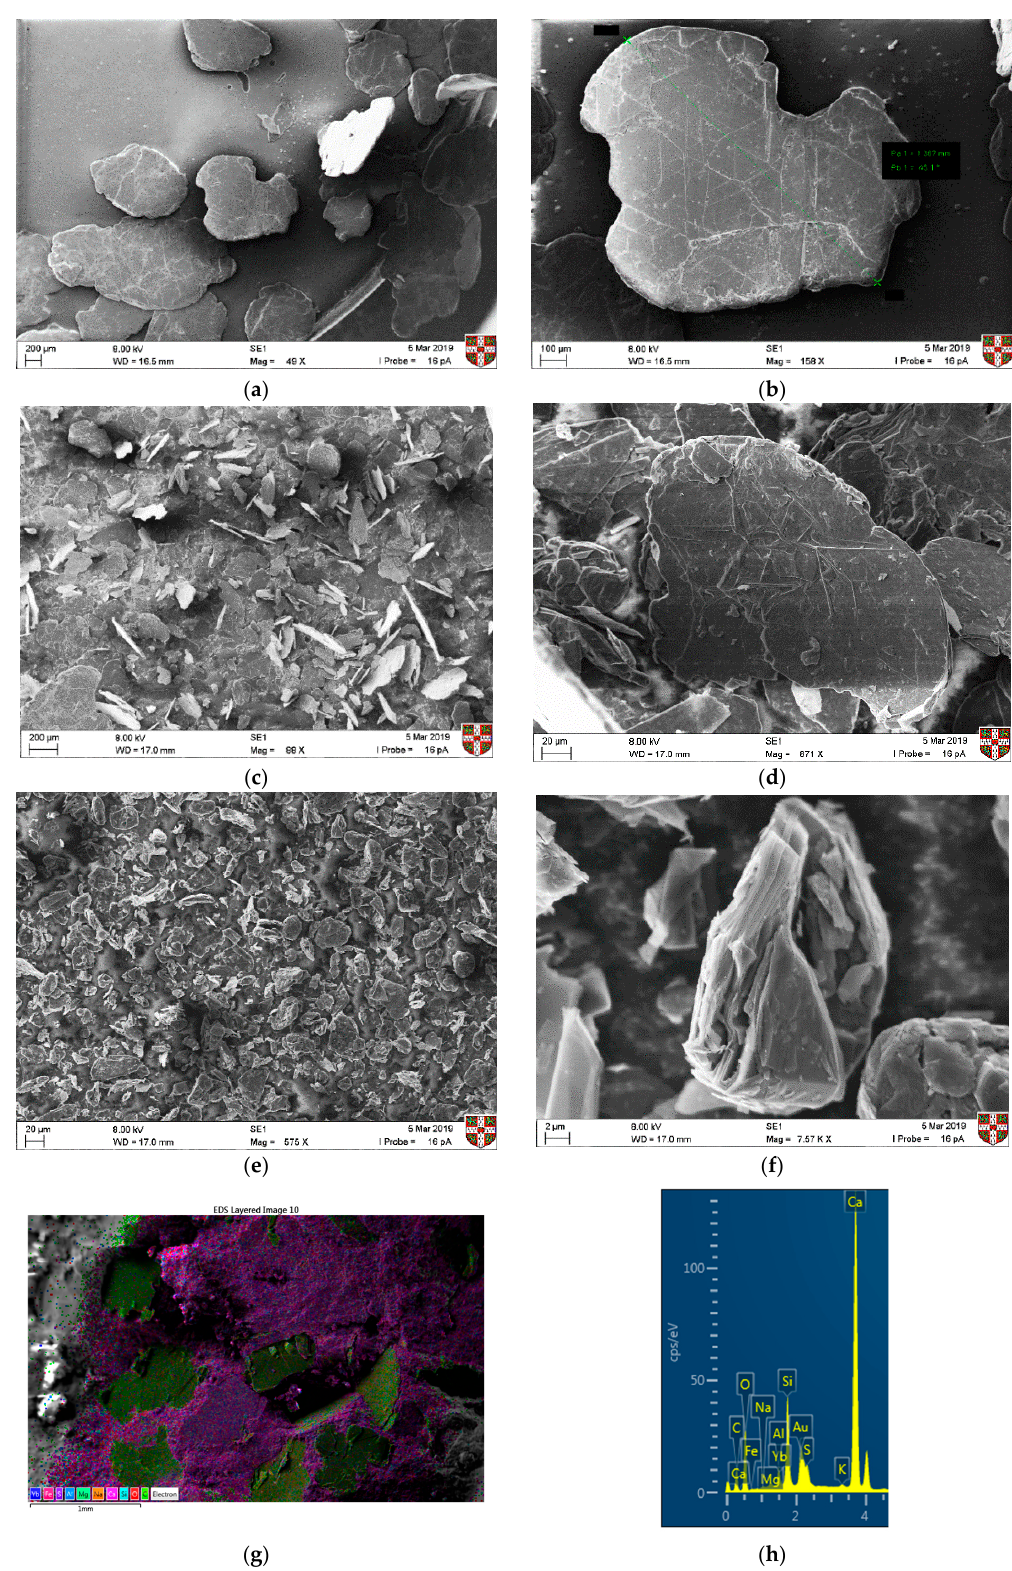
Figure 3. SEM images of the three graphite products, with two di ff erent magnification images for each: coarse graphite ( a , b ), medium graphite ( c , d ), fine graphite ( e , f ), and SEM–EDX confirming good dispersion of the coarse graphite flakes at 28 days ( g,h